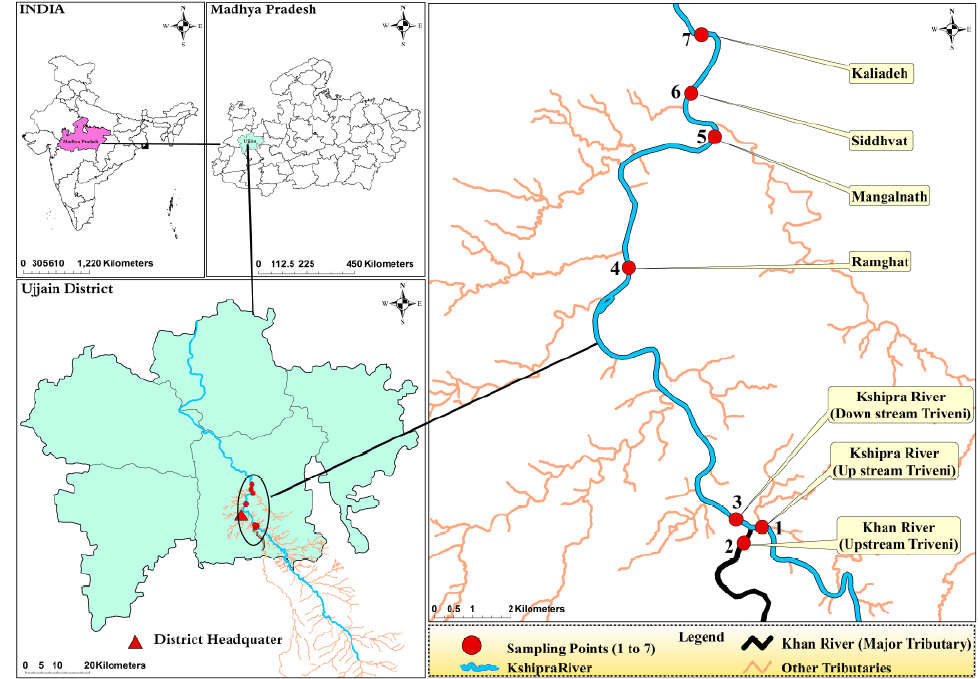
Figure 1. Geographical location of the study site. The map shows (clockwise) India, Madhya Pradesh, the sampling points on the Kshipra river, and Ujjain district. Note: Necessary required data are digitized into shape files. Spatial formatted vector data are converted into shape files and georeferenced.